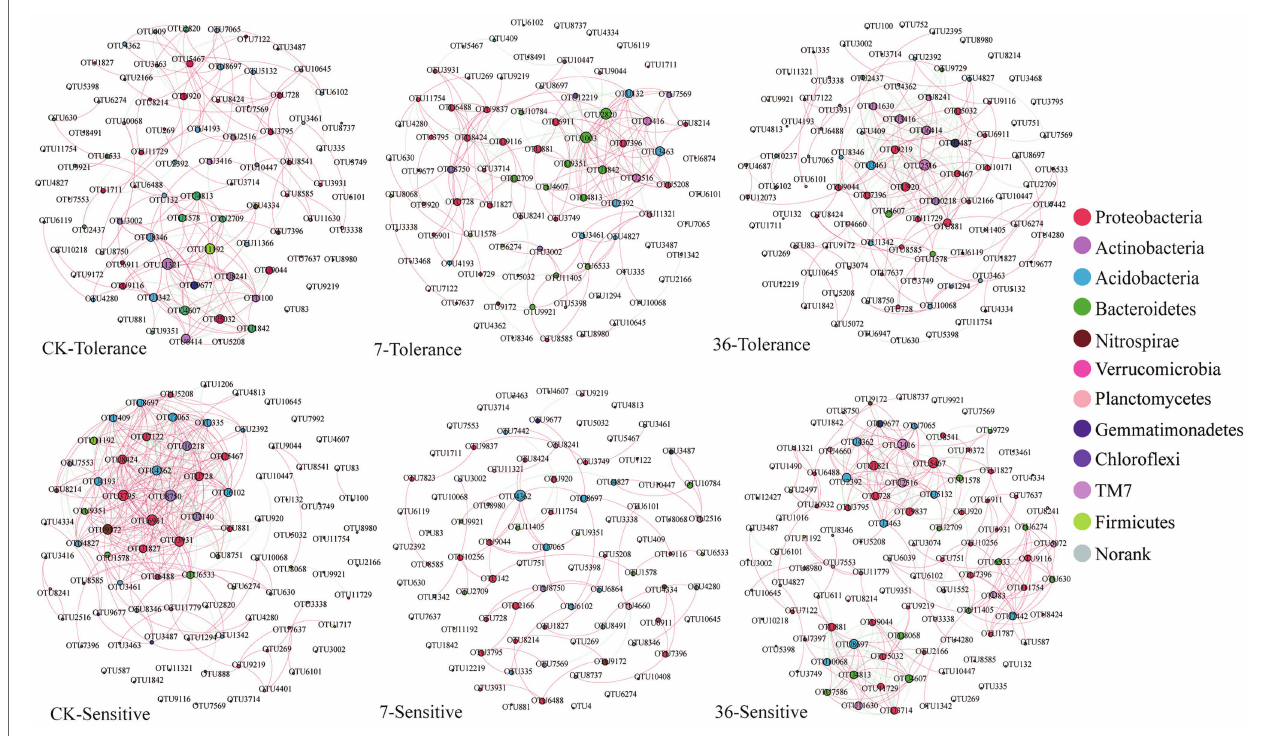
FIGURE 6 | Network analysis of the rhizosphere bacterial community from different treatments. Nodes represent OTUs coded by phyla and are scaled by the number of connections (node degree). Connections are plotted at r > 0.8 (positive correlation, red) or r < − 0.8 (negative correlation, blue) and p <